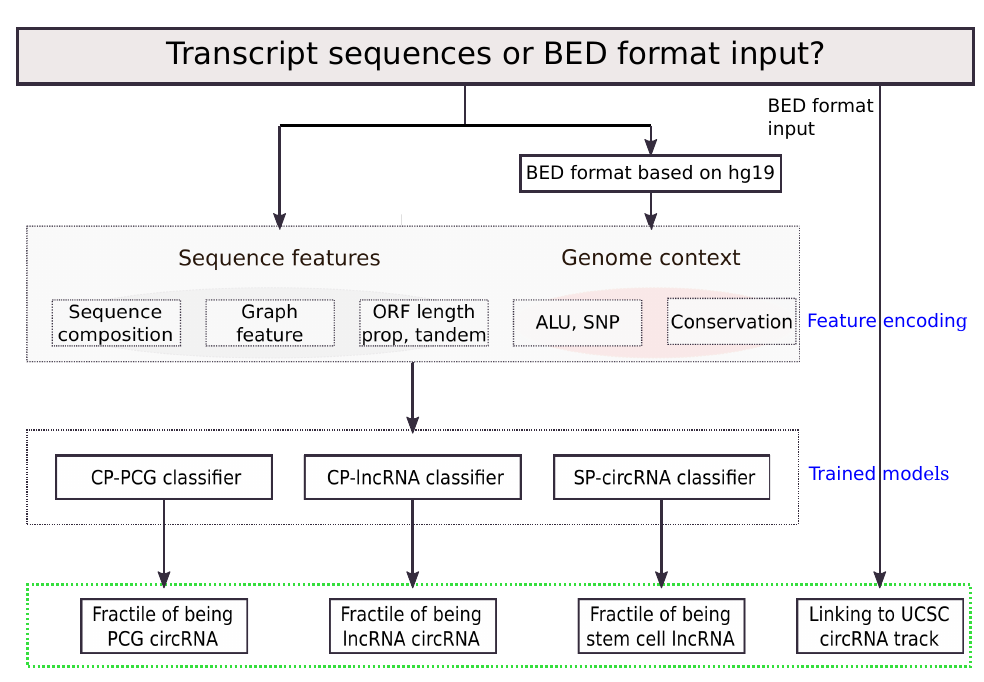
Figure 1. Flowchart of the WebCircRNA framework. BED: browser extensible data; ORF: open reading frame; ALU: transposable element; SNP: single nucleotide polymorphism; CP: circular RNA potential; PCG: protein coding gene; lncRNA: long non-coding RNA; SP: stem cell potential; circRNA: circular RNA; UCSC: University of California, San